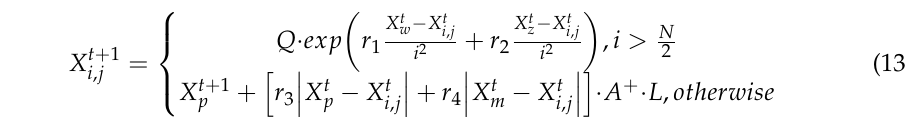
Figure 4. Two-sample learning strategy.